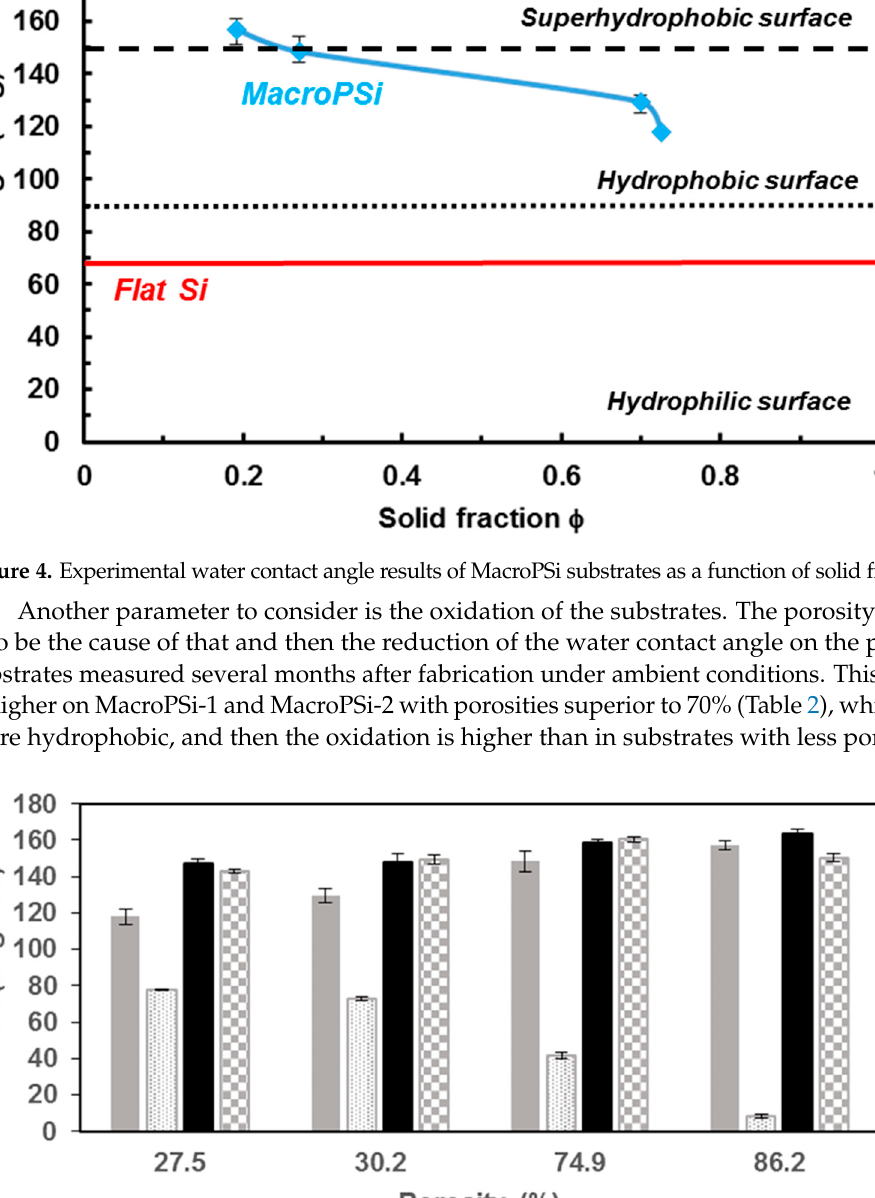
5 of 11 Figure 3. ESEM images of the studied macroporous silicon substrates: ( a ) MacroPSi-1; ( b ) MacroPSi- 2; ( c ) MacroPSi-3; ( d ) MacroPSi-4. Figure 4 illustrates the water contact angles (WCAs) on porous structures as a